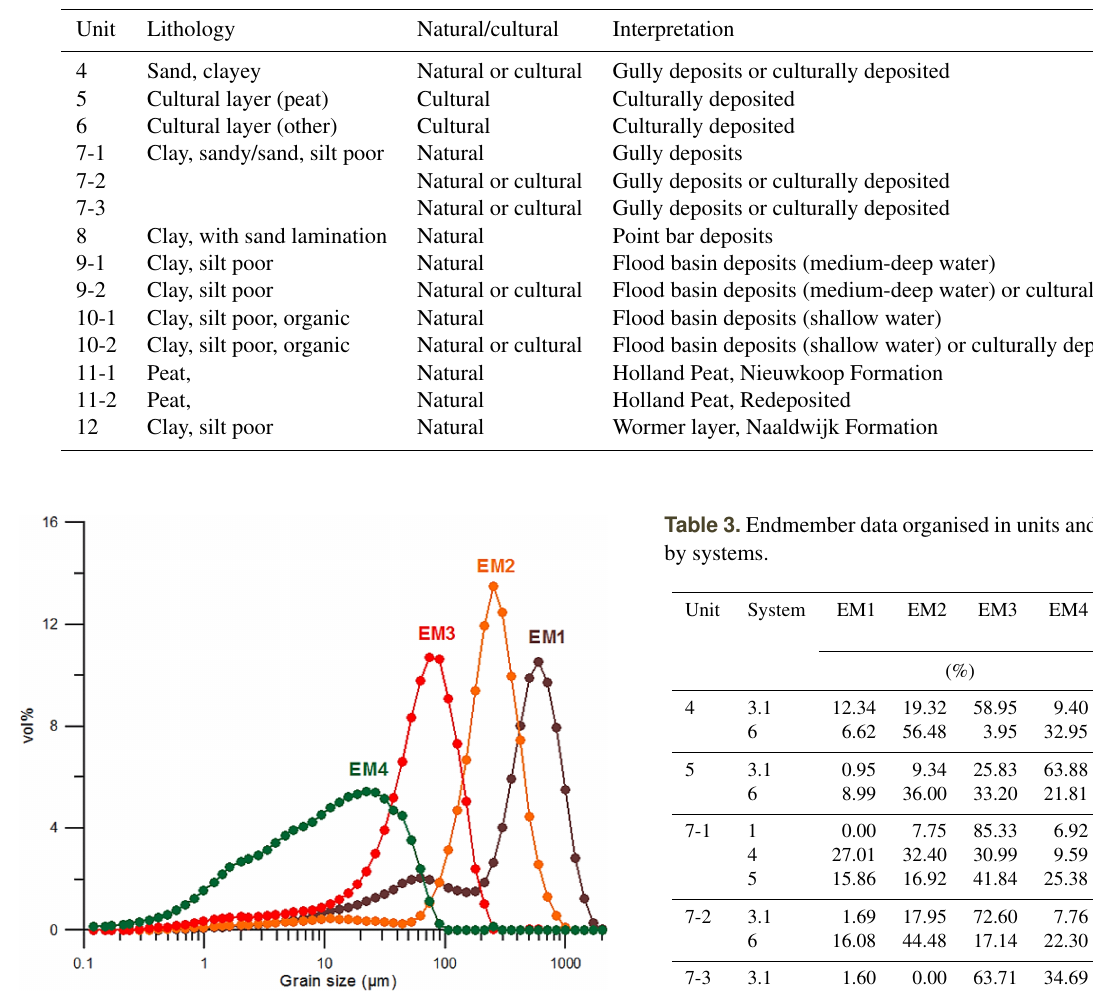
Table 2. All units described in this research above the Holland Peat layer belong to the Walcheren layer of the Naaldwijk Formation and the anthropogenous top layers.